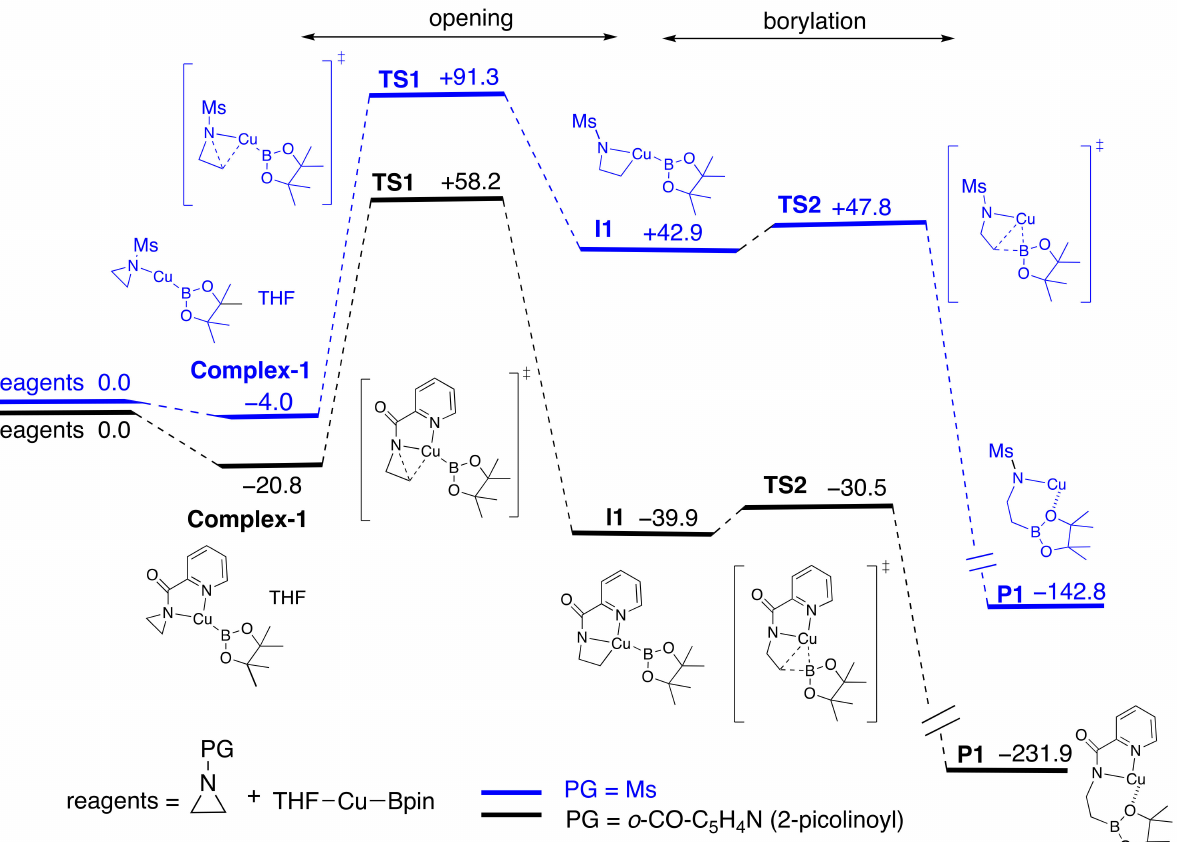
Figure 1. Comparative calculated reaction energy profile of N -mesyl-azirdine (blue) and N -(2-picolinoyl)-aziridine (black) using the mono-copper-boron borylation adduct (the ∆ G values are in kJ/mol). See also Table 2